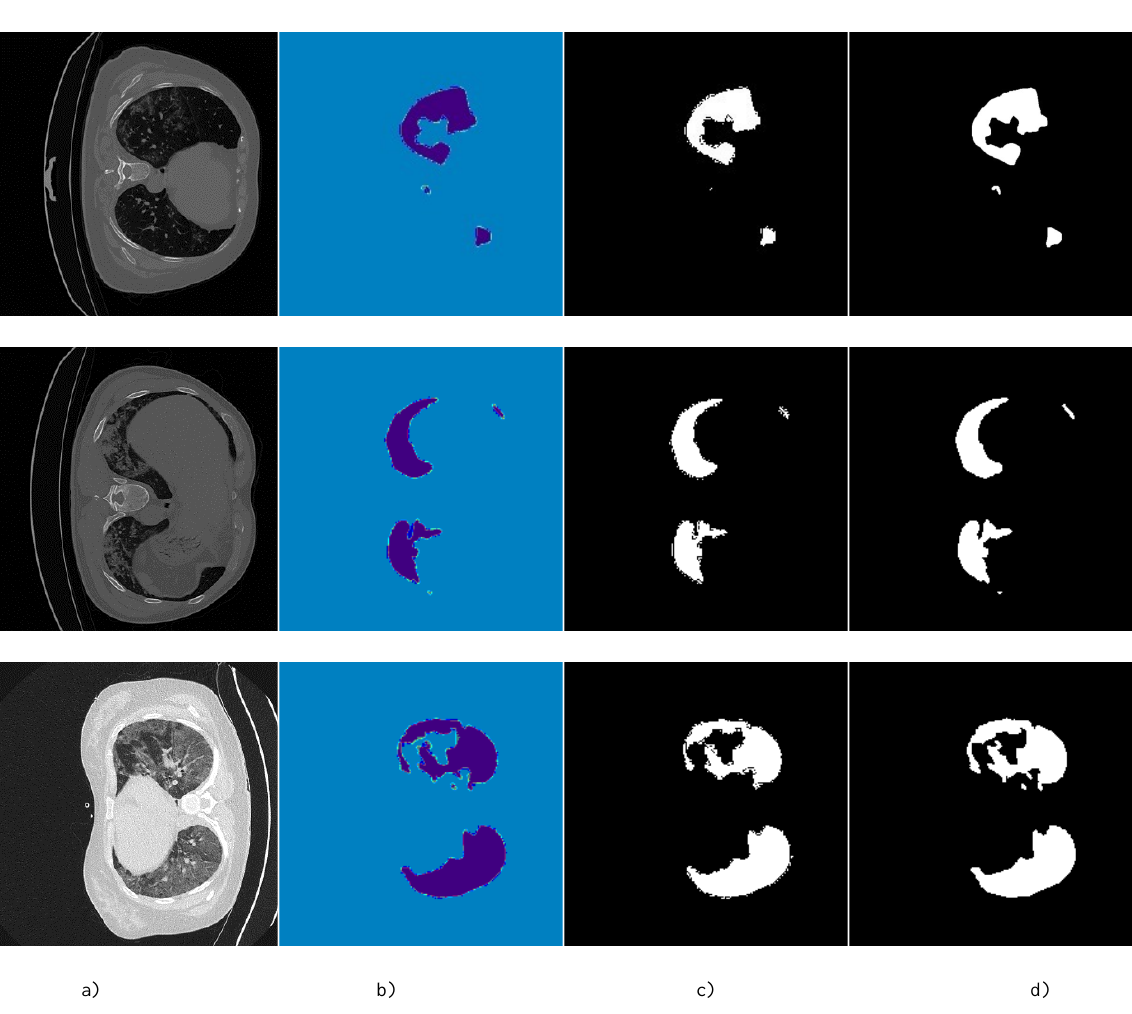
Cross-correlation: The standard statistical